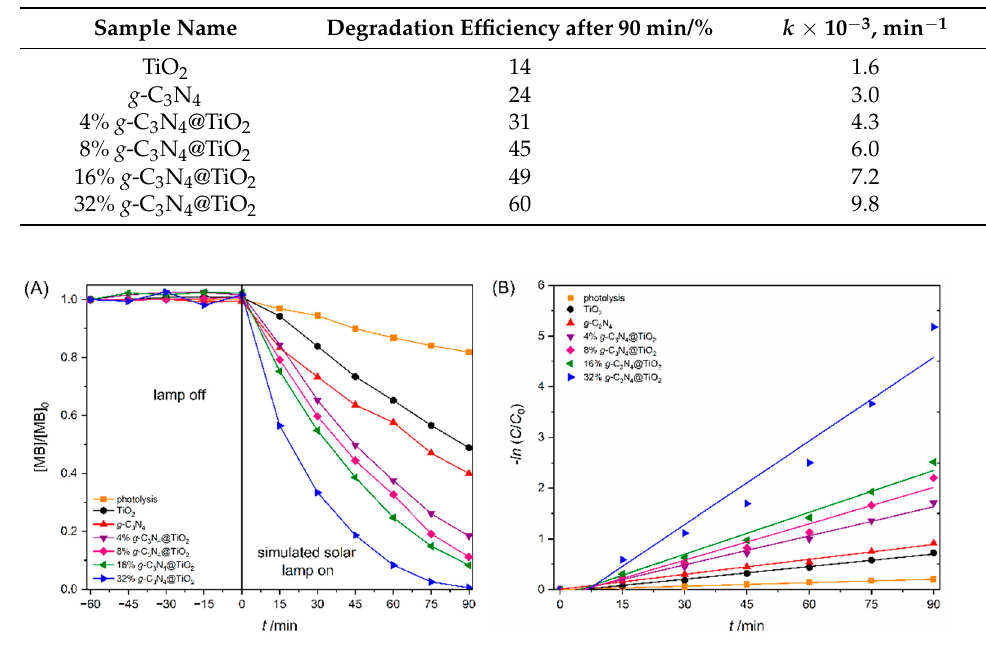
Table 2. The values of degradation efficiency of MB under UV-A irradiation and first-order rate constant ( k ).